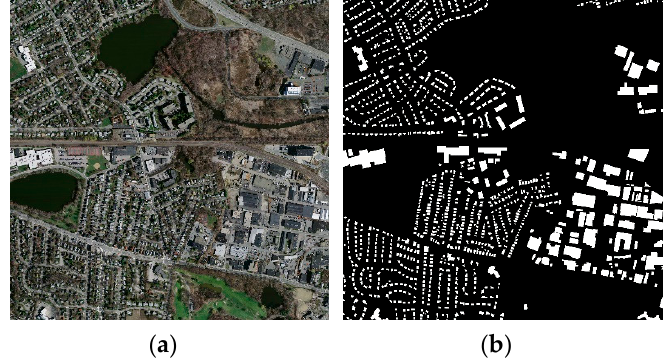
Figure 9. Original image and label. ( a ) Image; ( b ) Label. Remote Sens. 2017 , 9 , x FOR PEER REVIEW